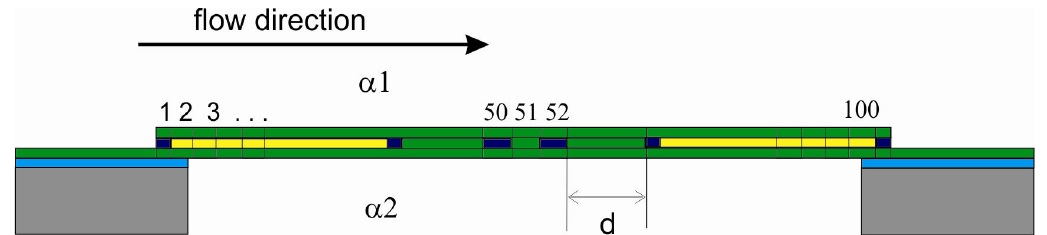
Figure 3. Schematic representation of the one dimensional model where a cross section in the membrane is divided into 100 nodes. α 1 and α 2 are the wall heat transfer coefficients. d is the distance between heater and thermopile.